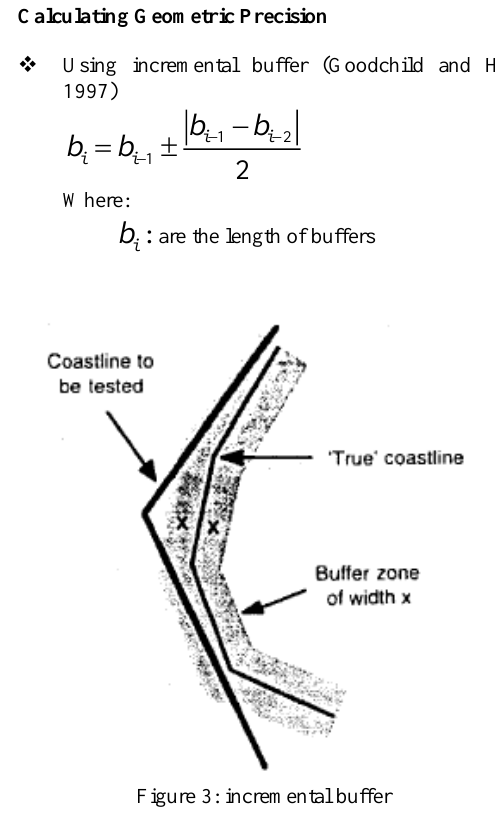
Figure 3: incremental buffer